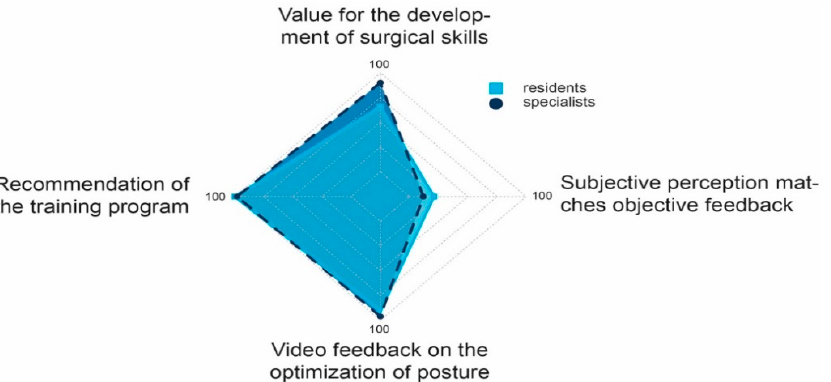
Figure 6. Median ratings of residents and specialists with regard to four questions plotted on the